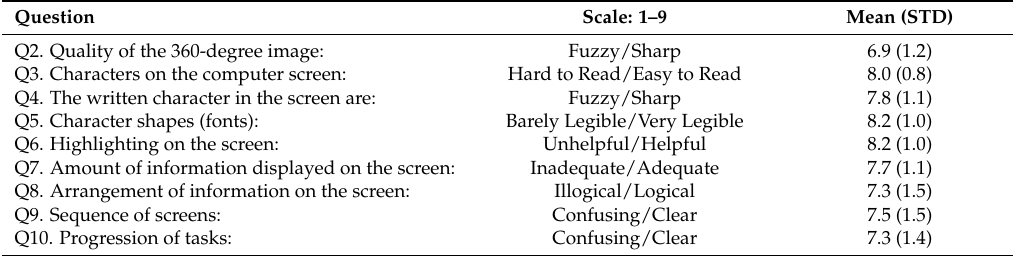
Table 5. Results of QUIS Part